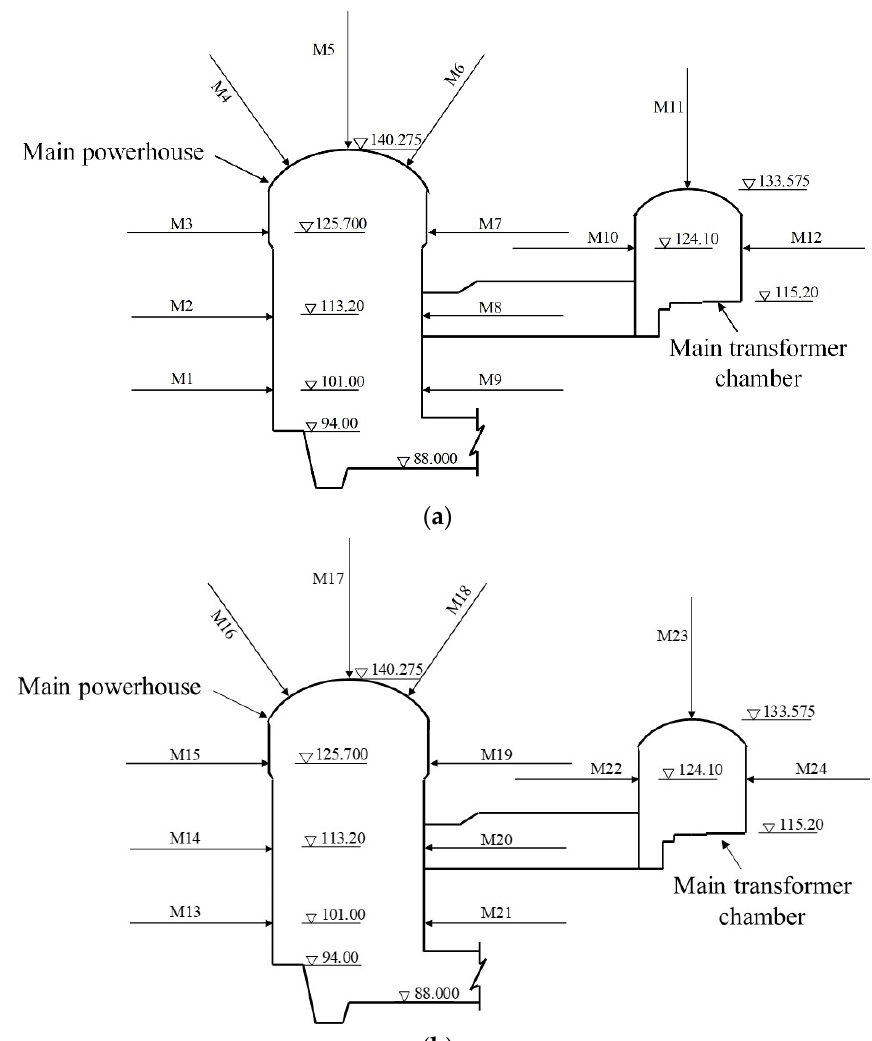
Figure 12. The layout map of the displacement monitoring points section. ( a ) The monitoring points at the 0 + 15 m section to the left of the powerhouse. ( b ) The monitoring points at the 0 + 54 m section to the left of the powerhouse.